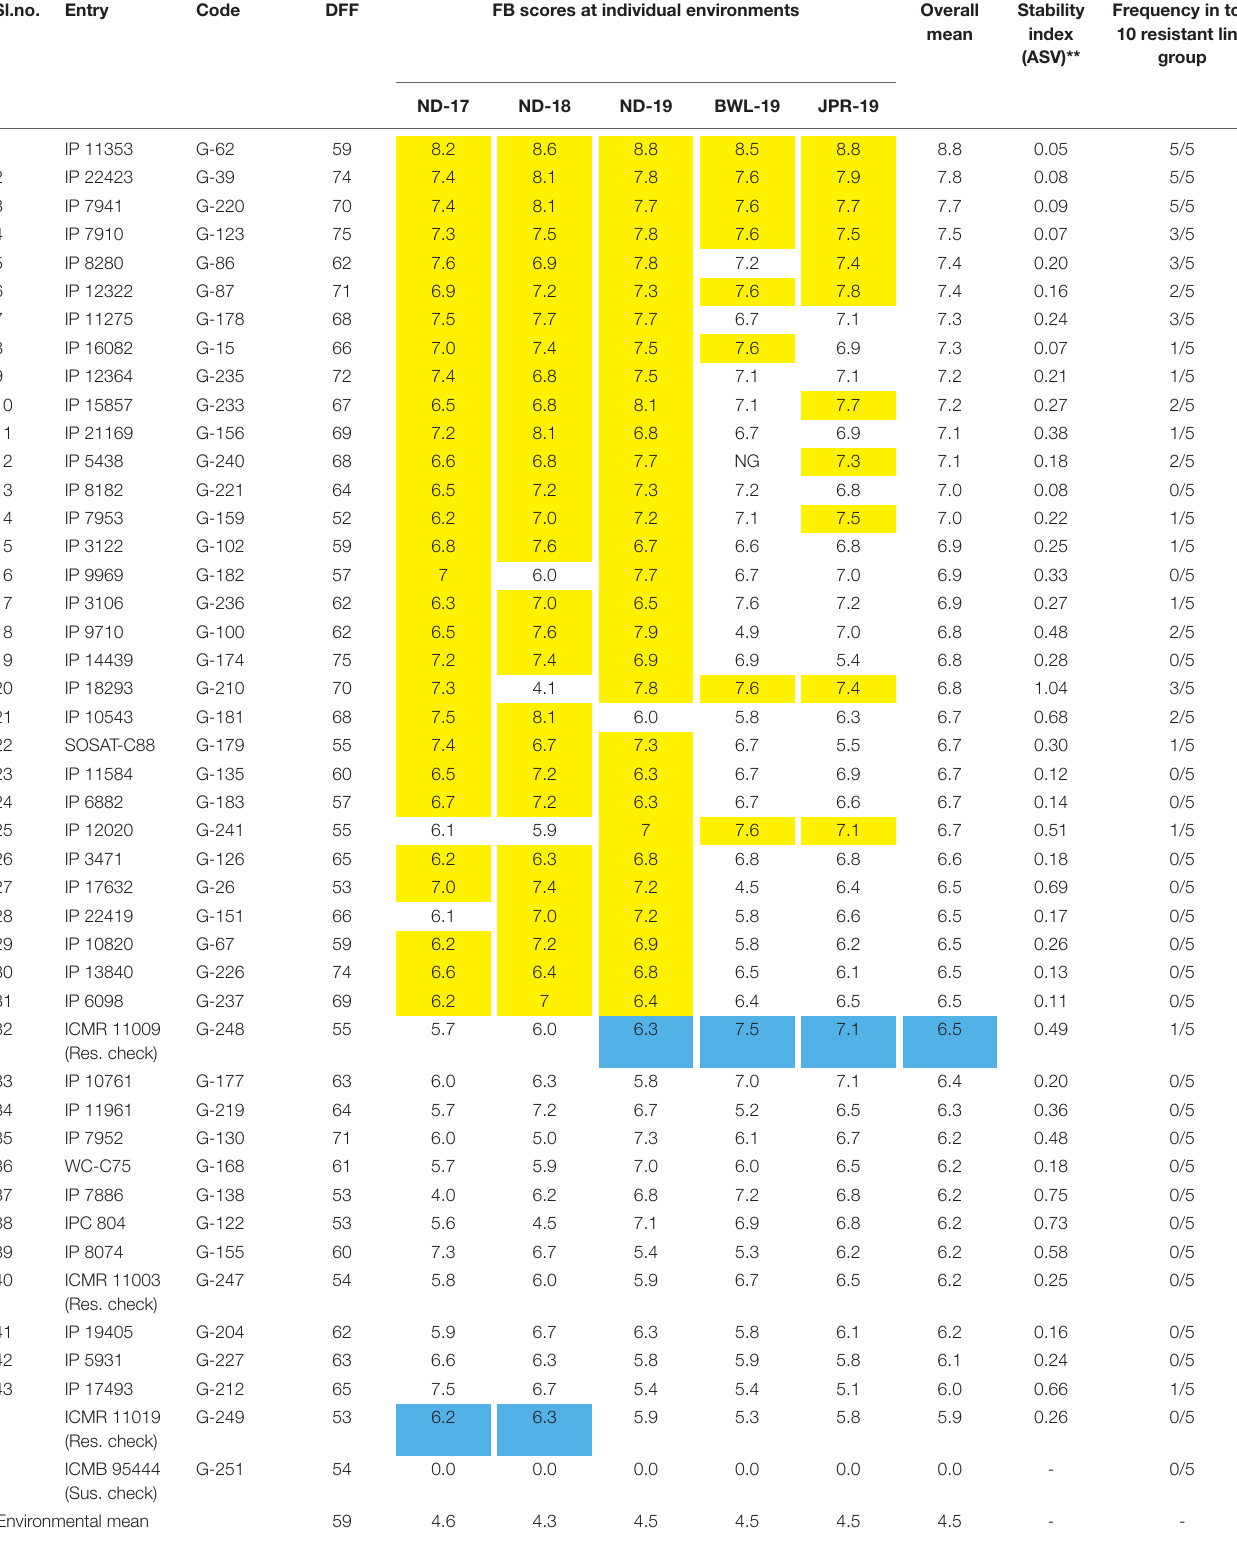
TABLE 2 | List of genotypes outperforming resistant checks for foliar blast resistance across environments. Sl.no. Entry Code DFF FB scores at individual environments Overall